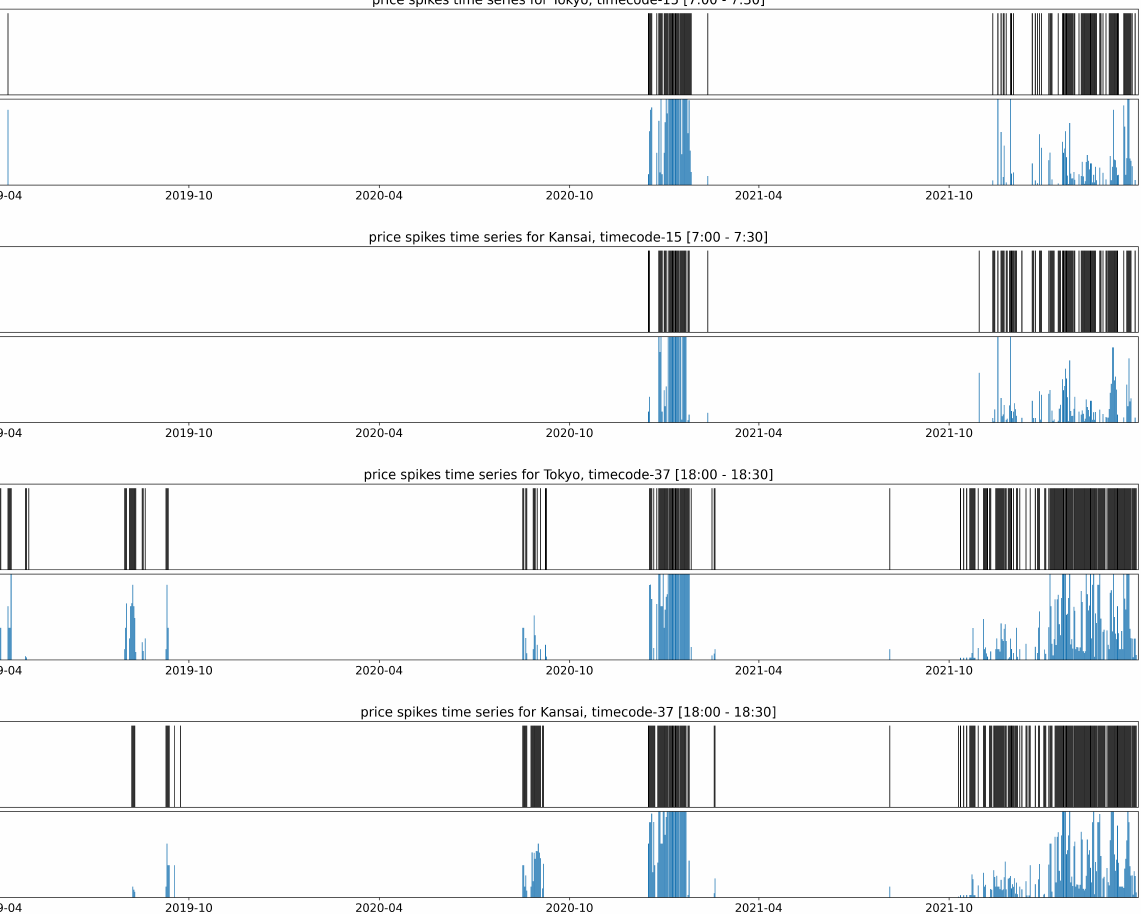
Figure 6. Temporal evolution of price spikes time series for selected areas and trading time periods. The vertical axis of the magnitude plots is truncated at 40 JPY/kWh though much higher spike magnitudes have also been observed. The axis truncation provides a better clarity for the